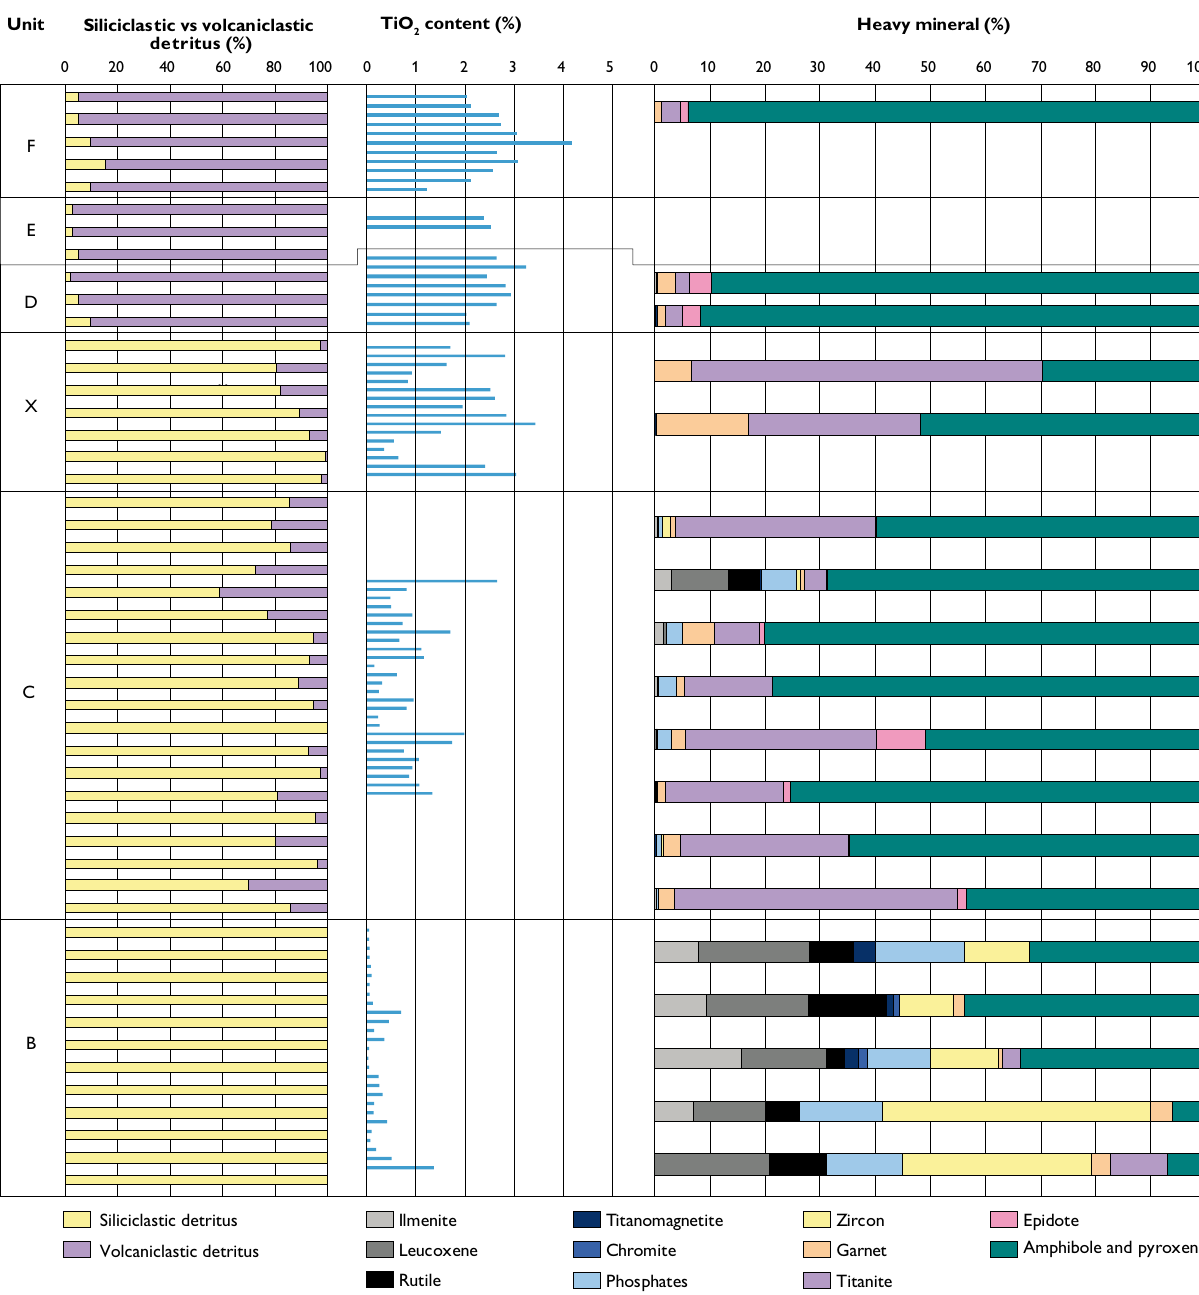
Fig. 2. Bulk rock TiO content and previously published heavy mineral assemblages for sub- and intra-basaltic sandstones (Larsen et al . 2016). Unit B : sub- 2 basaltic sandstone of the Schjelderup Member. Units C, X, D, E, F : intra-basaltic sandstones. Siliciclastic detritus dominates the sub-basaltic sandstones whereas the volcaniclastic content increase upwards. Titanite comprises a relatively large proportion of the heavy minerals in the earliest and second intra- content is even higher in the later intra-basaltic sandstones. basaltic sandstones, even though the TiO 2